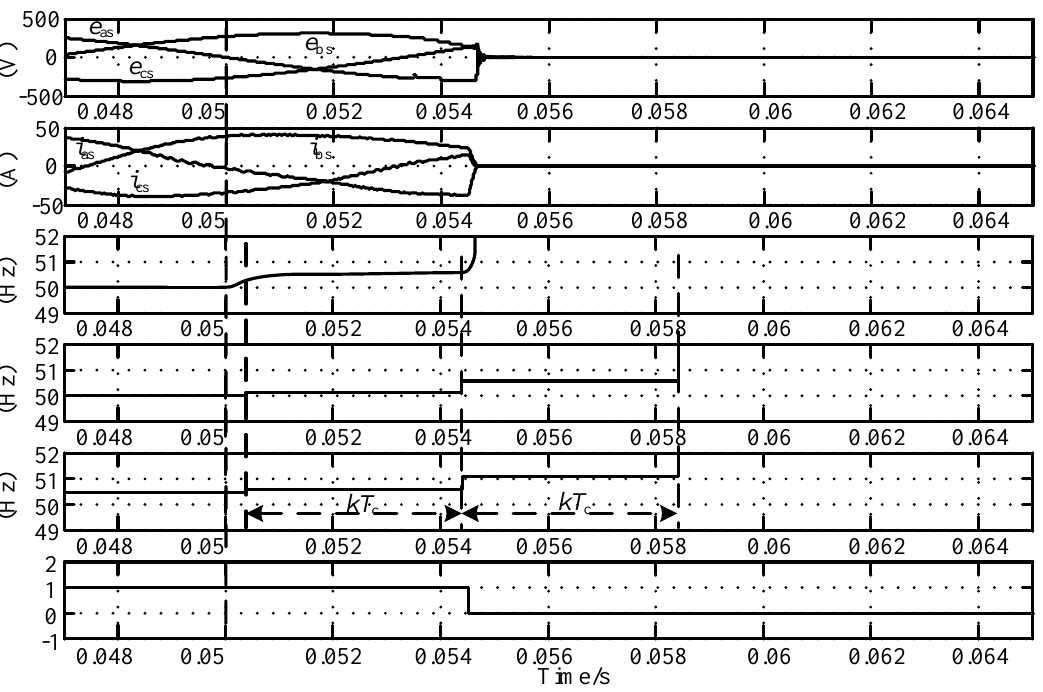
Figure 8. The simulation results with the inductive load.